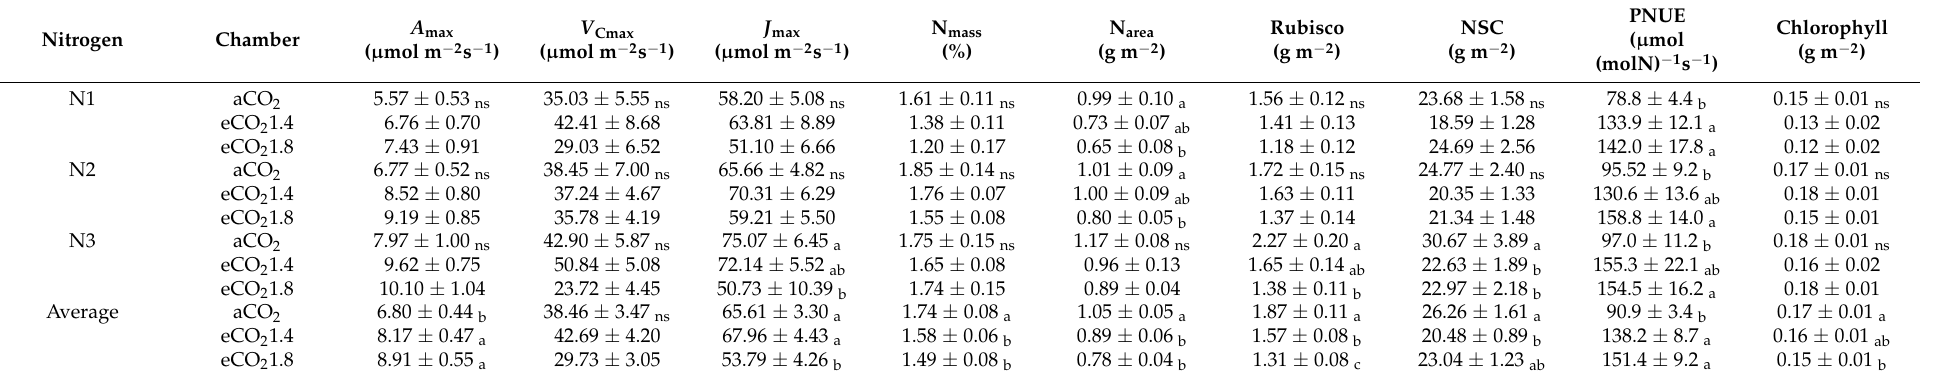
Table 2. Average ± standard error of maximum photosynthetic rate ( A max ), maximum carboxylation rate ( V Cmax ), RuBP regeneration rate ( J max ), nitrogen per unit mass (N mass ), nitrogen per unit area (N area ), Rubisco per unit area (Rubisco), nonstructural carbohydrates per unit area (NSC), photosynthetic N use efficiency (PNUE), chlorophyll per unit area (Chlorophyll) measured in Fraxinus rhynchophylla grown at three different CO 2 chambers (ambient: aCO 2 ; ambient × 1.4: eCO 2 1.4; ambient × 1.8: eCO 2 1.8) and three different N treatments